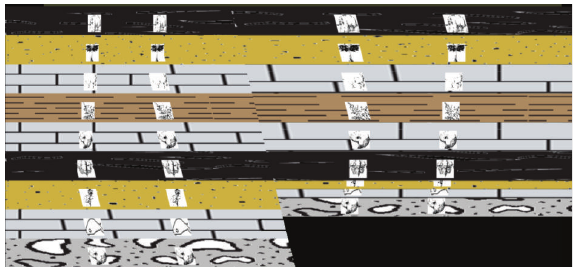
Figure 6: Layer-cake structure created in SMALLab